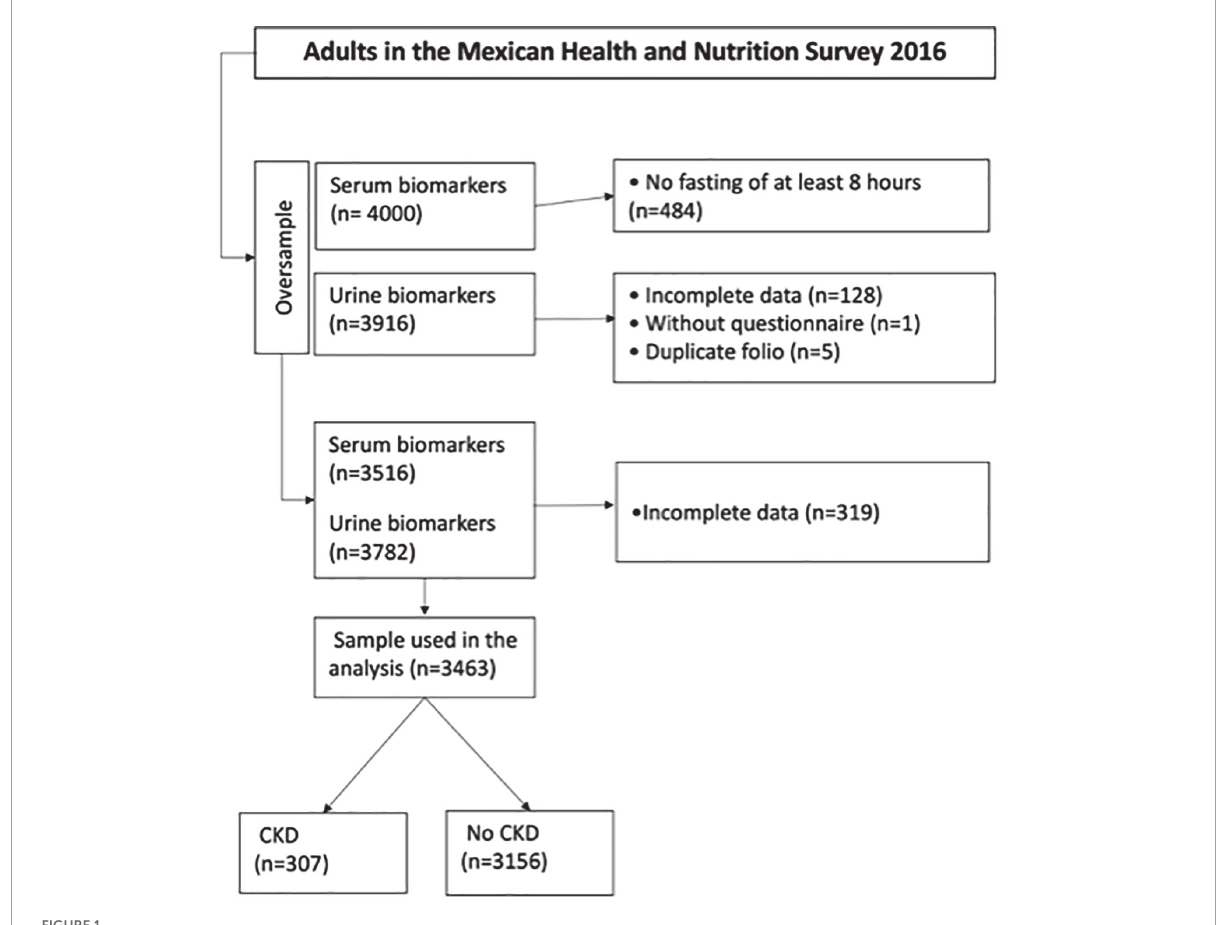
FIGURE1 Flowchart of the sample